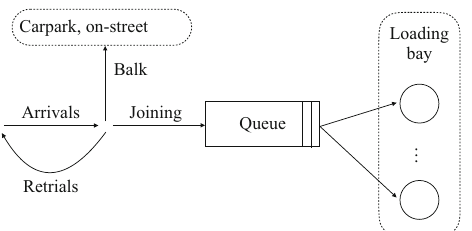
Fig. 2 Queueing system representation of a freight parking system of a retail